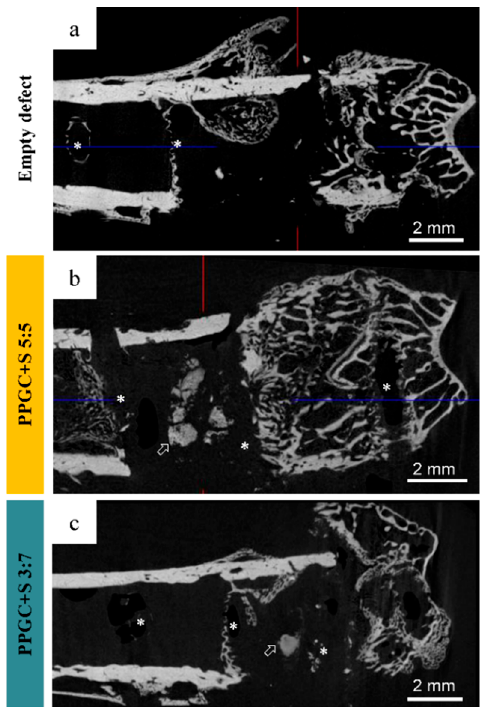
Figure 5. Femora embedded in Technovit scanned on a micro-CT (SkyScan 1173, Bruker microCT). Bone cross-sections without a material ( a , empty defect), after implantation of PPGC + S 5:5 ( b ) and PPGC + S 3:7 ( c ). The remaining material is indicated by arrows. Asterisks indicate positions of removed screws for T-plate fixation.